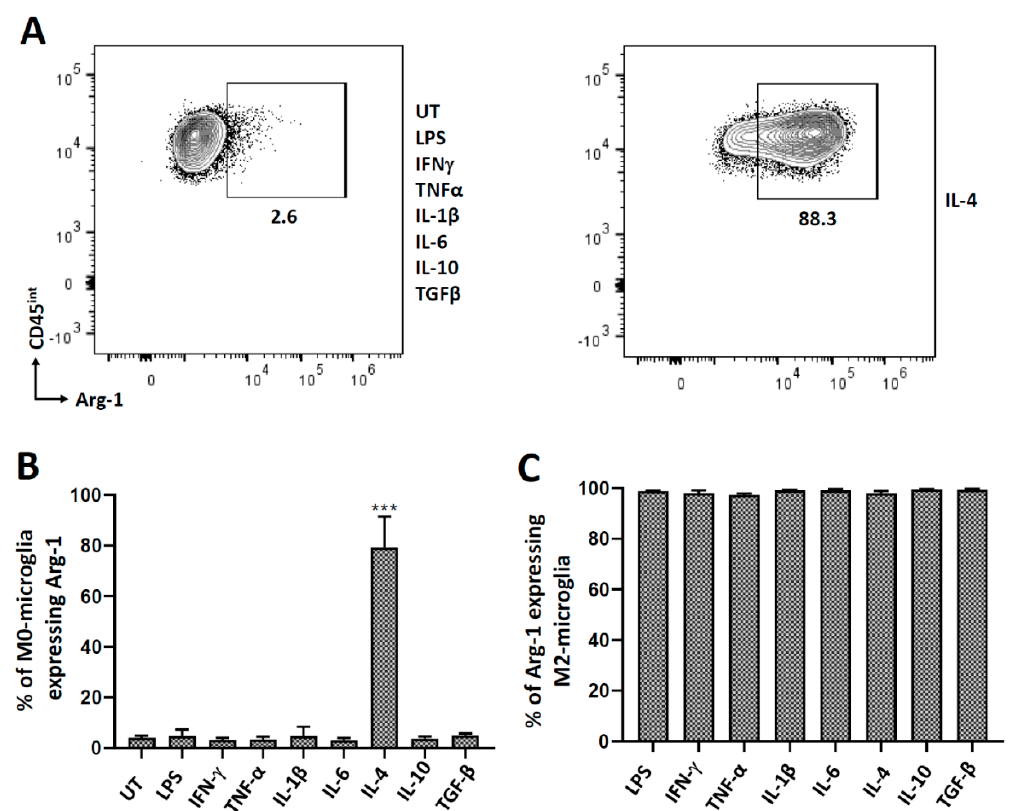
Figure 4. Arginase-1 (Arg-1) expression in microglial cells. Non-polarized, primary murine microglia were treated with several pro- and anti-inflammatory cytokines and analyzed for the expression of Arg-1 after 24 h of treatment. M2-polarized cells were subsequently treated with various pro- and anti-inflammatory cytokines for 24 h followed by assessment for the expression of Arg-1. ( A ) Representative contour plot of microglial cells (CD45 int ) expressing Arg-1 after treatment with various pro- and anti-inflammatory mediators. ( B ) Representative graph showing the expression of Arg-1 after treatment with select pro- and anti-inflammatory mediators. ( C ) Graphical representation of Arg-1 expression in IL-4 treated (M2-polarized) microglia after 24 h of treatment with various pro- and anti-inflammatory cytokines. UT-untreated control. Experiments were carried out three times with duplicate wells. *** p < 0.001.